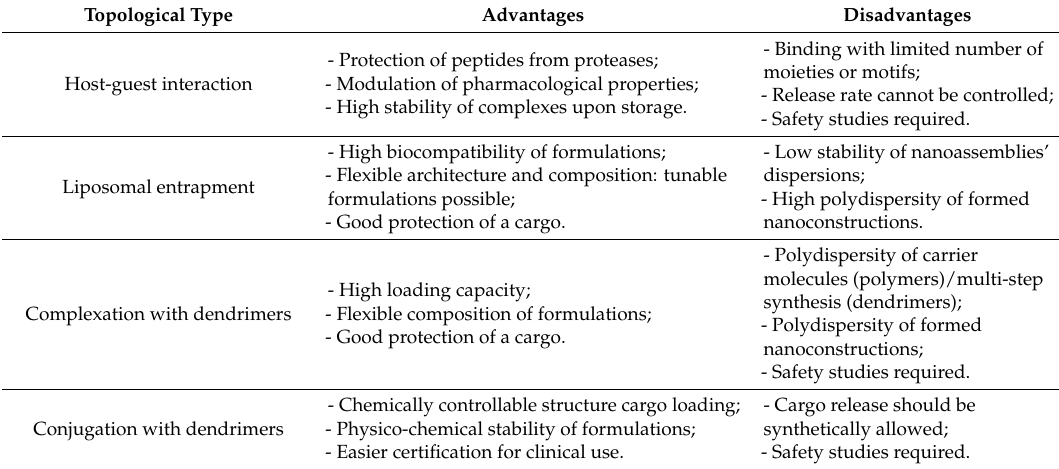
Table 1. Advantages and disadvantages of the topological types